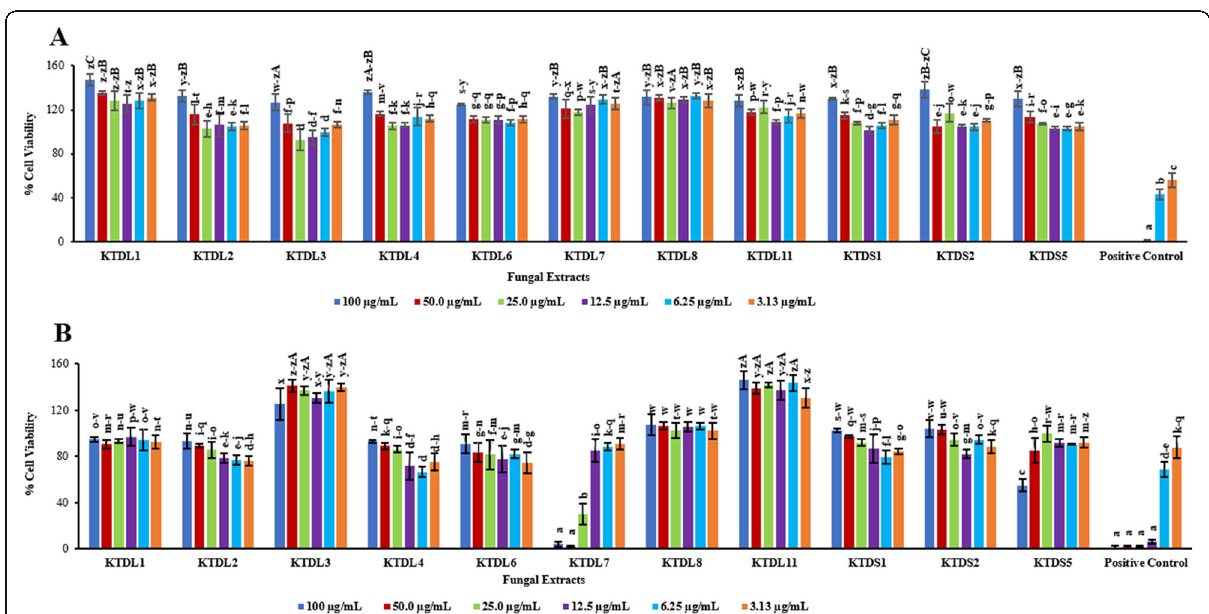
Fig. 1 A summative profile of bioactivity activity of fungal extracts on ( a ) A549 lung carcinoma cells and ( b ) UMG87 glioblastoma cells after 96 h of exposure. Columns in the histograms represent the mean ± SD ( n = 3) of fungal crude extracts tested at six different concentrations ranging from 3.13 to 100 μ g/mL. The positive control was auranofin and the alphabets above the columns represent significant differences among various concentrations of